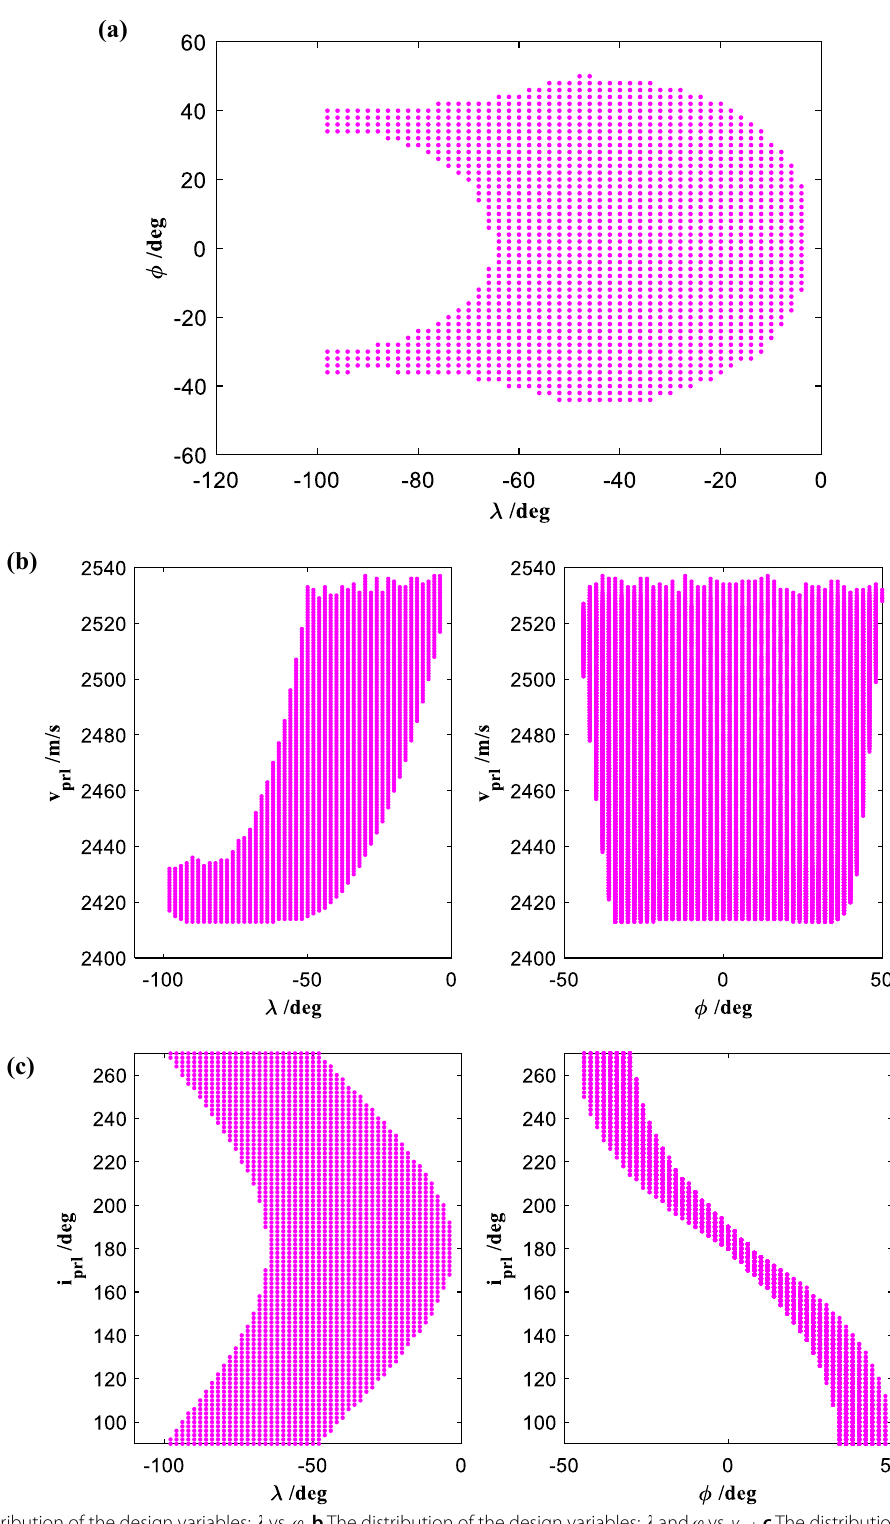
Fig. 6 a The distribution of the design variables: (cid:31) vs. ϕ . b The distribution of the design variables: (cid:31) and ϕ vs. v prl . c The distribution of the design variables: (cid:31) and ϕ vs. i prl . d The inclination and LAN in LVLH frame and LCF